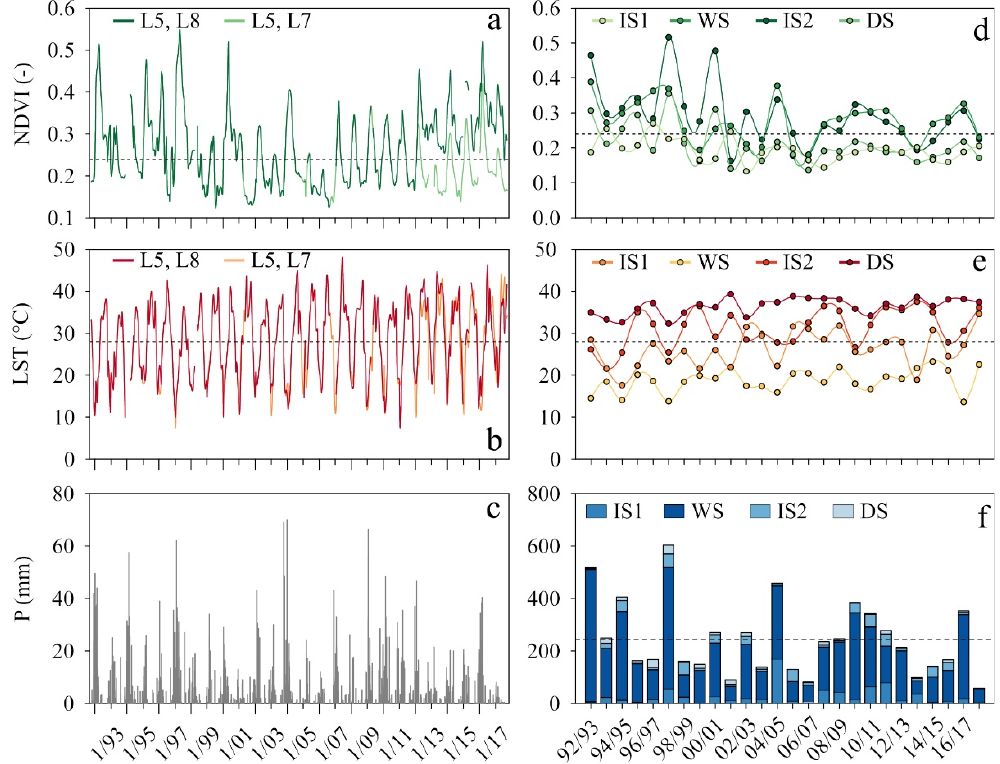
Figure 3. ( a , b ) Highlands average surface reflectance-derived monthly Normalized Difference Vegetation Index (NDVI) and Land Surface Temperature (LST) (L5, L7, L8 represents Landsat datasets), ( c ) daily precipitation (P) from Agua Caliente and Guadalupe Valley weather stations, Baja California, Mexico, from 1992/93 to 2017/18 hydrological years, the x-axis indicates month/year. ( d – f ) Seasonal NDVI, LST, and P, respectively; (IS1, intervening season 1; WS, wet season; IS2, intervening season 2; DS, dry season). Broken lines represent annual mean historical values (NDVI, 0.24; LST, 28 ◦ C; P, 245 mm). The x -axis indicates the hydrological